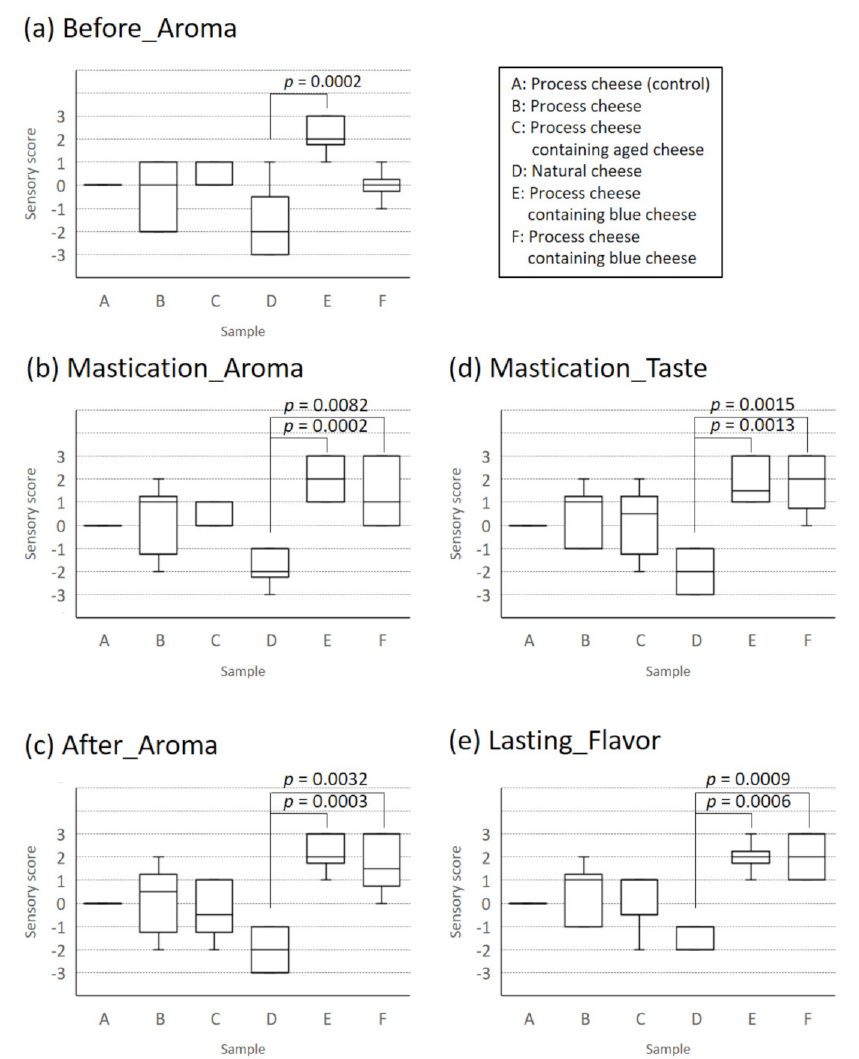
Figure 4. Comparison of aroma intensity scores and related sensory scores for 6 cheeses: ( a ) Be- fore_Aroma; ( b ) Mastication_Aroma; ( c ) After_Aroma; ( d ) Mastication_Taste; ( e )